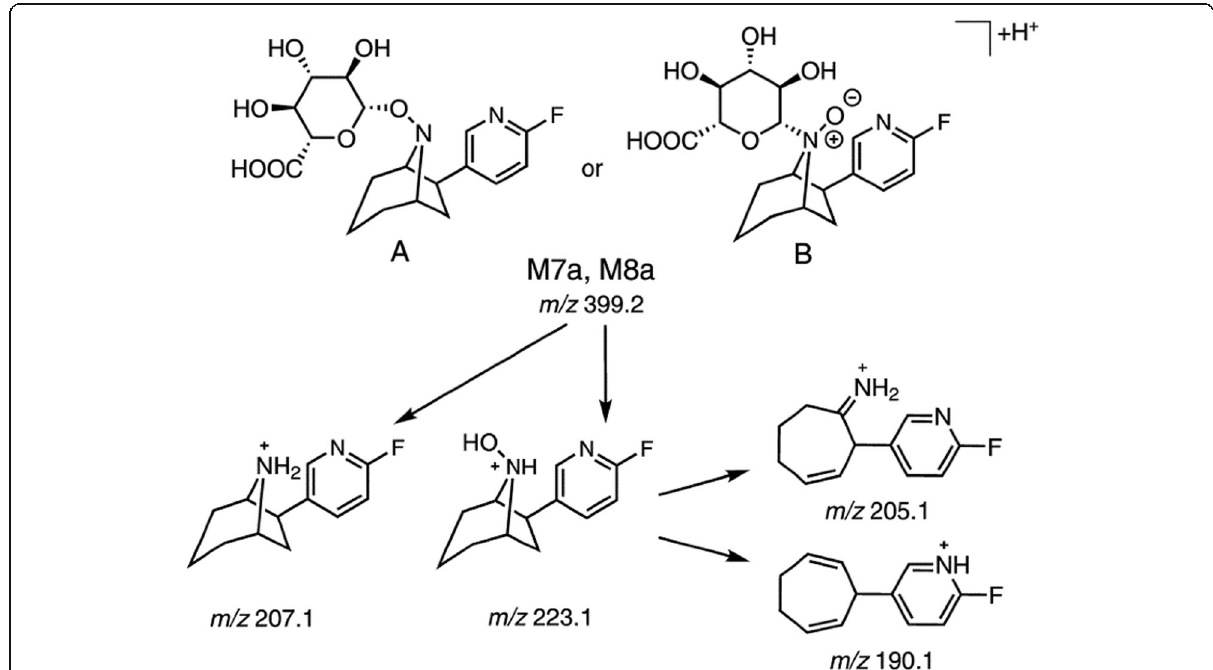
Fig. 8 Proposed structures and fragmentation pathways shown for glucuronide conjugates M7a and M8a, drawn as N- O -glucuronide (A) and N+(O − )-glucuronide (B); similarly, for enantiomers M7b and M8b. Adapted with permission from Ref.